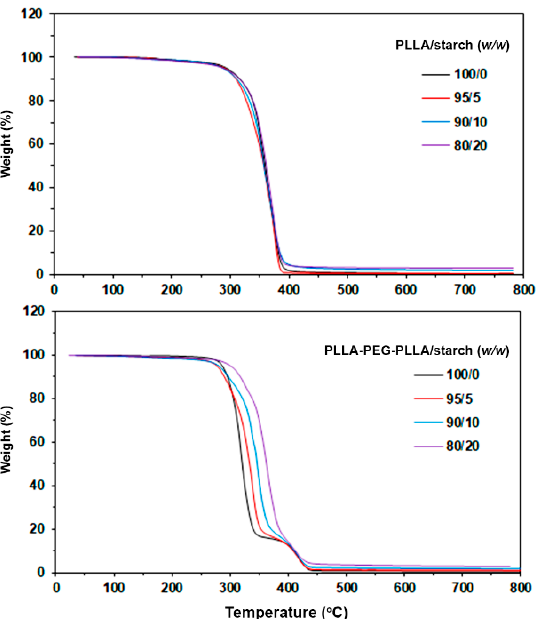
Figure 3. TG thermograms of ( above ) PLLA/starch and ( below ) PLLA-PEG-PLLA/starch composites with various blend ratios.